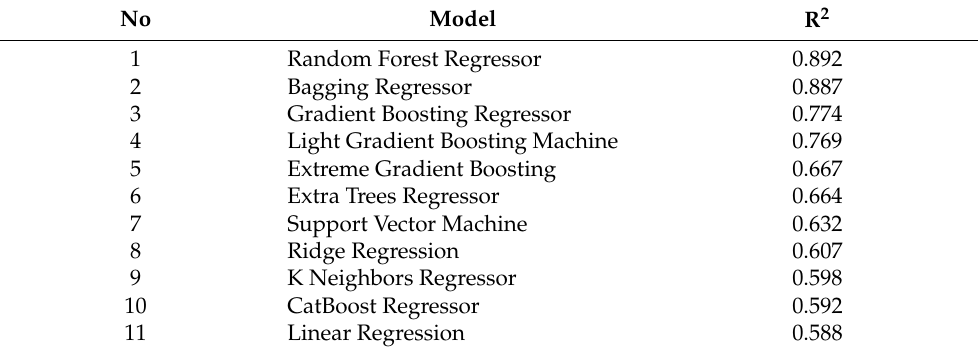
Table 2. Performance of various machine learning models (R 2 for test